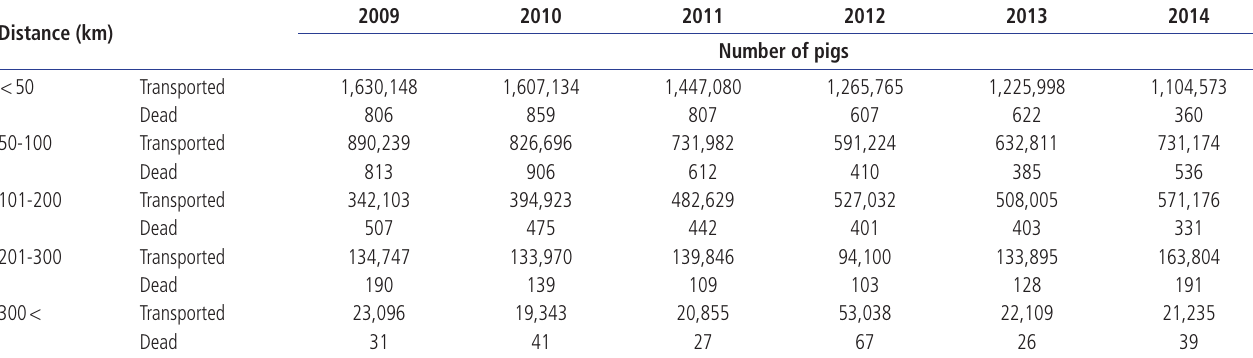
Table 1. The numbers of finisher pigs transported to slaughterhouses and numbers of pigs dying as a result of their transport for monitored distances Distance (km)